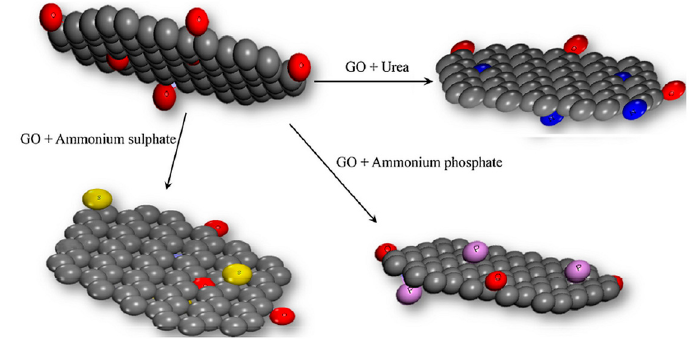
Figure 6. The decoration of GO sheets with heteroatoms (Reprinted with permission from ref. [48] 2020 Elsevier).